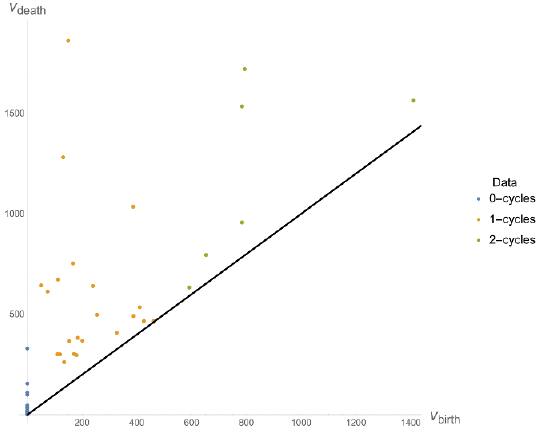
Figure 7 . The persistence diagram for the (cid:12)nal population obtained with the Metropolis algorithm. There is signi(cid:12)cantly more large scale structure to be observed than in the analogous plot on the bottom of (cid:12)gure